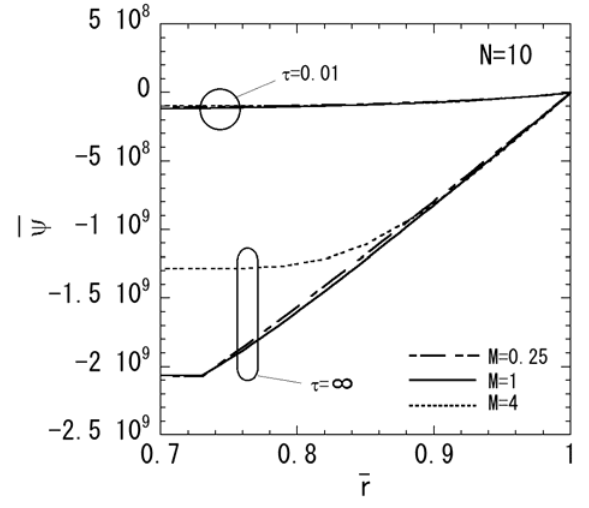
Figure 8. Variation of the magnetic potential ( 10 = N ).